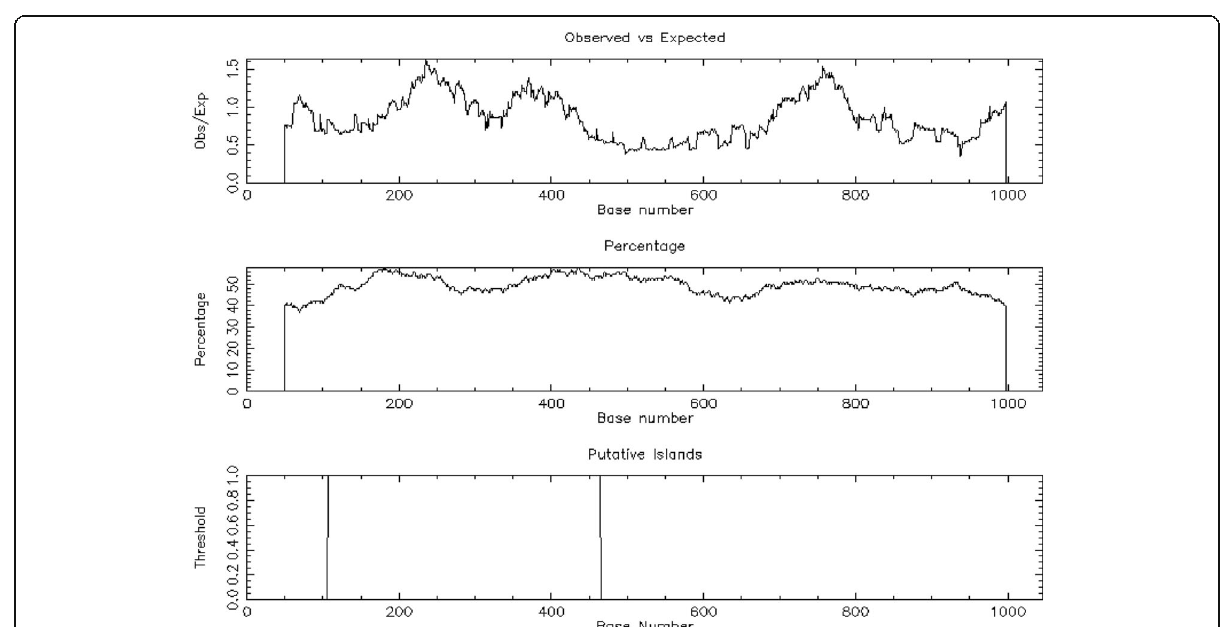
Fig. 5 CPGPLOT islands of ADH1, with length 358 (108 – 465)